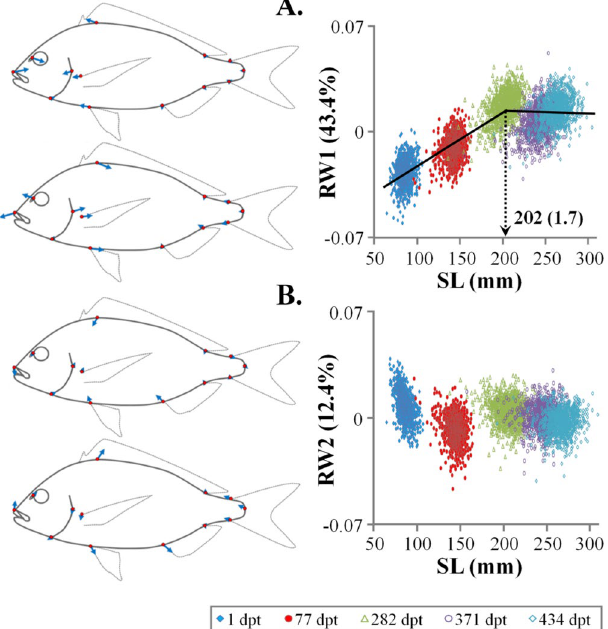
Figure 5. Relationship of ( A ) the first relative warp (RW1) and ( B ) the second relative warp (RW2) to standard length (SL) throughout the on-growing period. Vector diagrams demonstrate the components of shape change relative to the extreme values of Y-axes (on the observed scale).